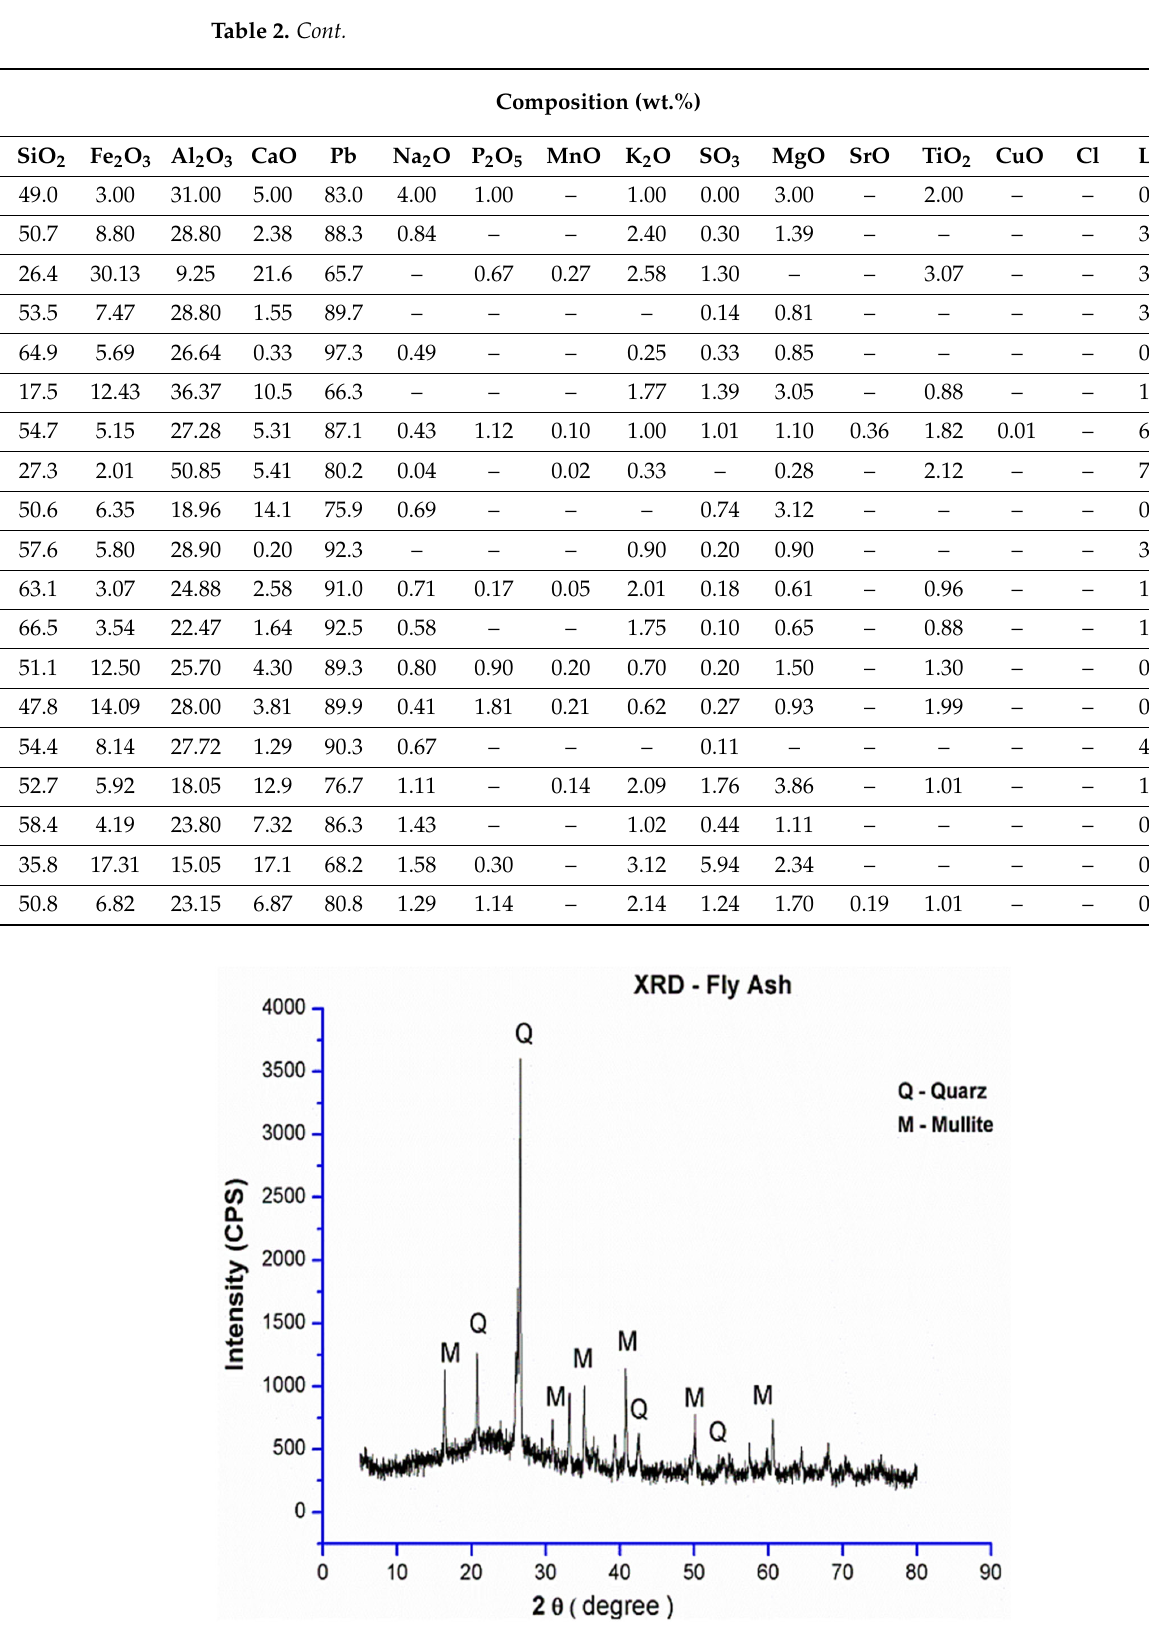
Figure 12. XRD of FA. Adapted from [113].